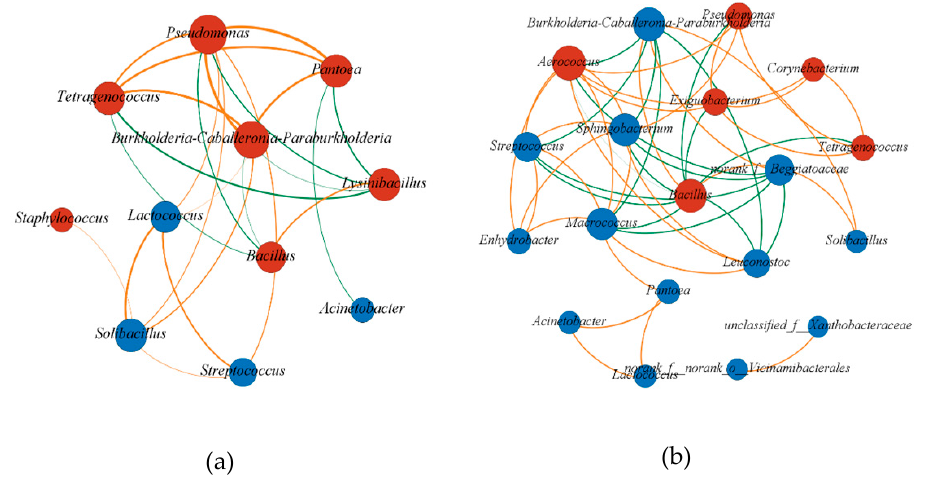
Figure 5. Co-occurrence network analysis of dominant genera in the early stage ( a ) and in the late stage ( b ), the red nodes are strongly flavor-related genus and the blue nodes are other dominant bacteria, the yellow side shows a positive correlation while the green side shows a negative correlation.